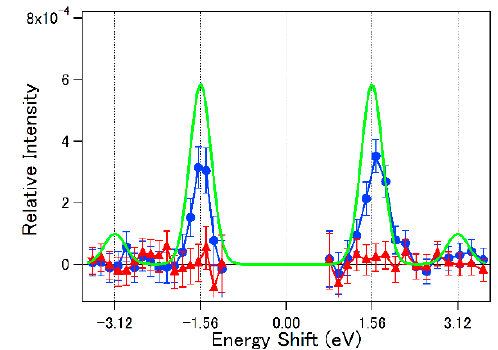
Figure 4. The energy spectra of the relative intensities of the LAES signals [9]. The relative intensities were normalized with respect to the peak intensity of the n = 0 scattering signal. Estimated statistical error bars were derived from the square roots of signal counts. The blue filled circles are the energy spectrum obtained after the subtraction of the backgrounds from the signals recorded with vertically polarized laser fields; the red filled triangles are the energy spectrum obtained after the subtraction of the backgrounds from the signals recorded with horizontally polarized laser fields; and the green solid line is a calculated spectrum of the LAES signals when the laser fields are vertically polarized. The experimental conditions were the same as those in Figure